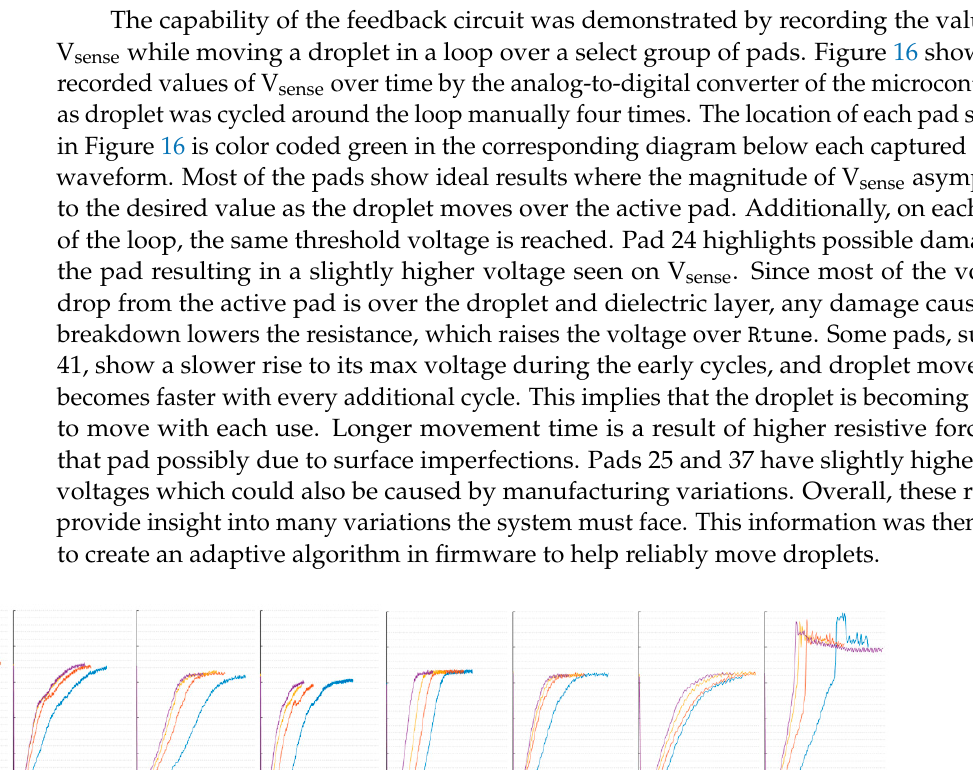
Figure 15. System current consumption for different activation voltage levels.